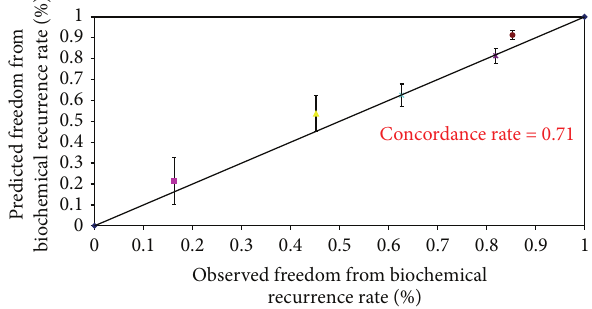
Figure 5: Observed versus predicted 10-year freedom from bio- chemical recurrence rates according to the 2006 Stephenson nomo-